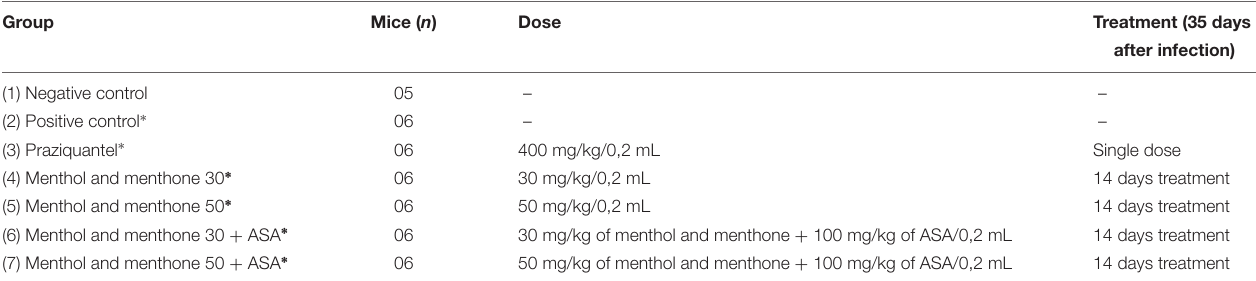
TABLE 1 | Experimental groups using Swiss mice in two independent experiments.